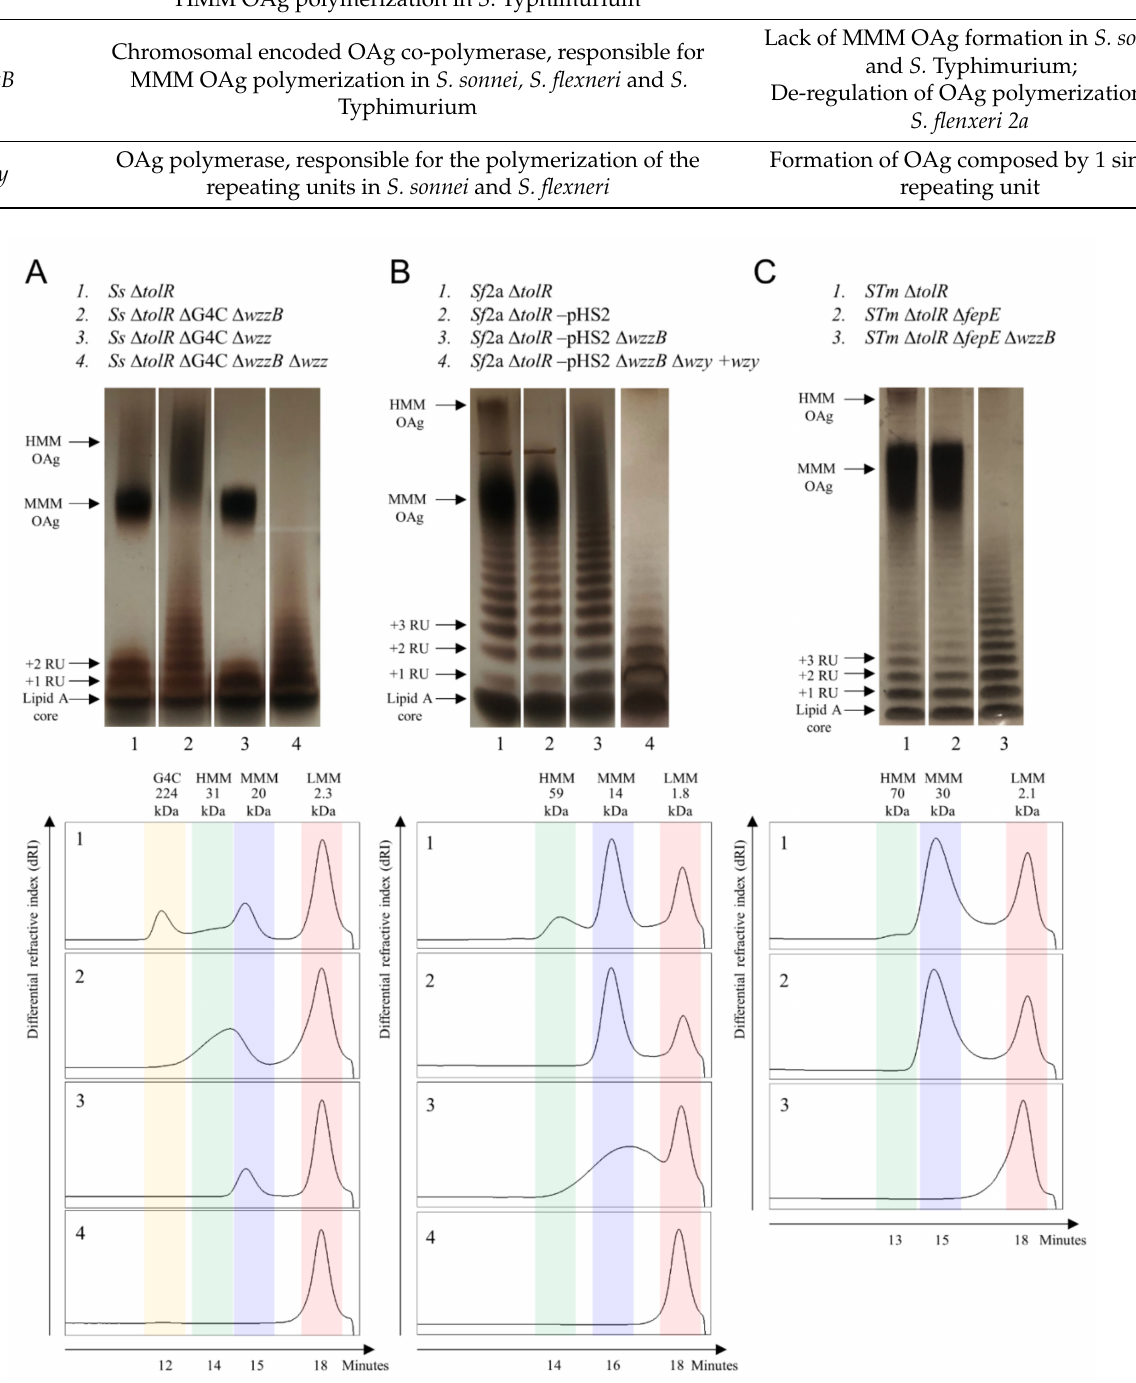
Figure 1. Silver staining of lipopolysaccharide (LPS) extracted from bacterial cells and HPLC–size exclusion chromatography (HPLC–SEC) profile differential refractive index (dRI) of sugar extracted from the corresponding generalized modules for membrane antigens (GMMA): ( A ) S. sonnei , ( B ) S. flexneri 2a, and ( C ) S.